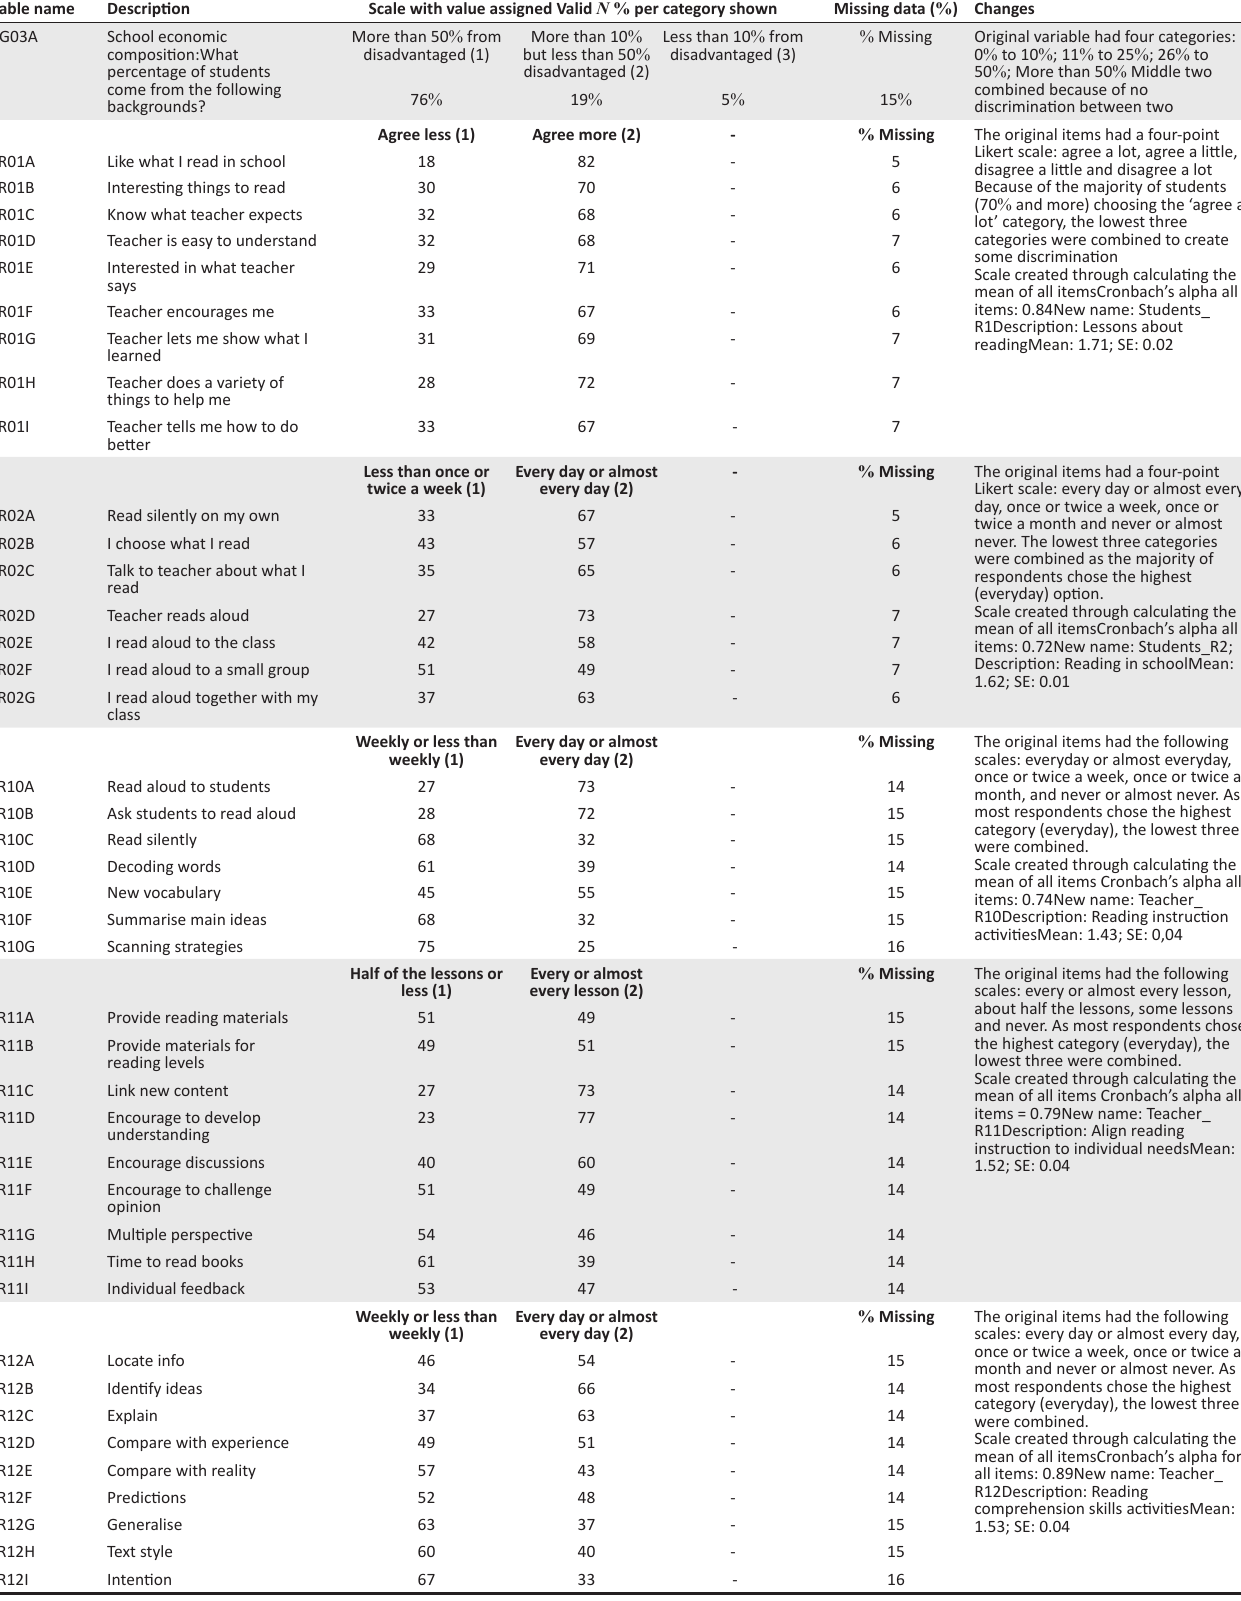
TABLE 1-A1: Summary of descriptive statistics of predictor used in regression